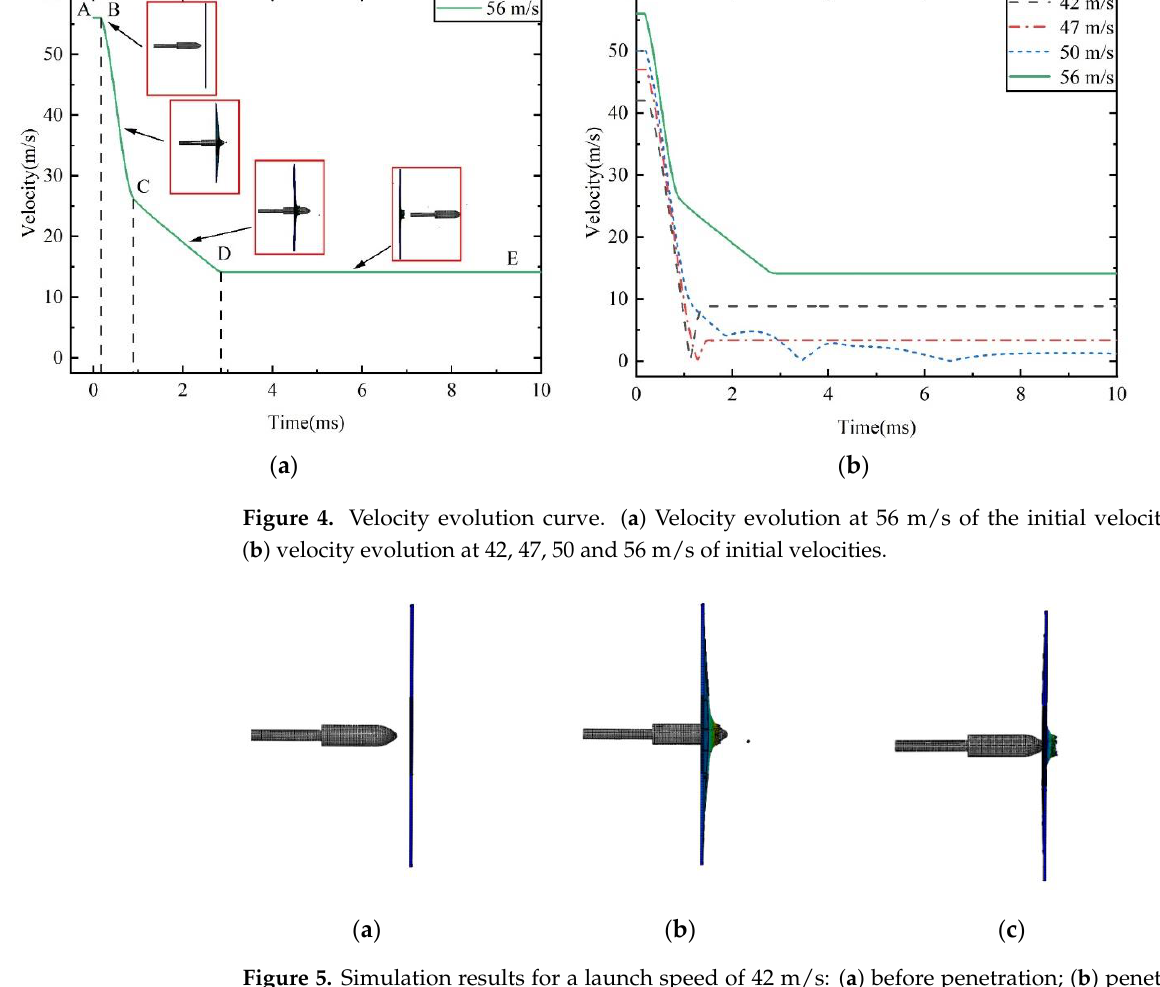
Figure 5. Simulation results for a launch speed of 42 m/s: ( a ) before penetration; ( b ) penetrating; ( c ) no penetration.